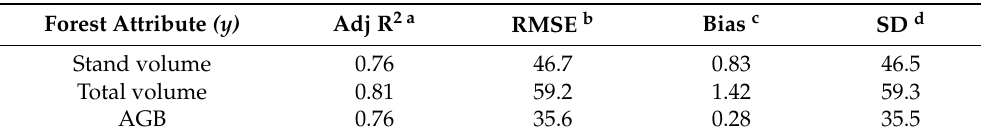
Table 5. Five-fold cross validation of stand volume, total volume, and aboveground biomass (AGB) models.